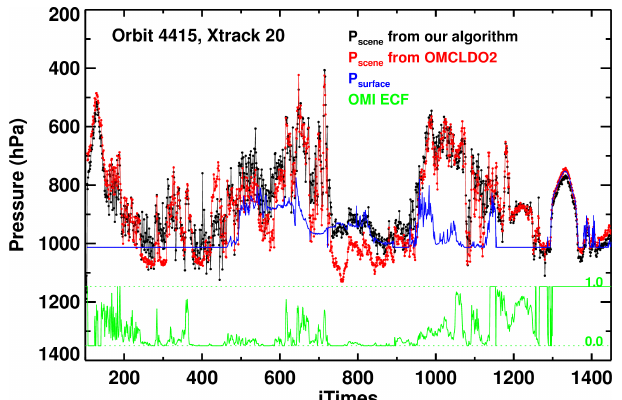
Figure 8. Comparison of scene pressures from our algorithm (black curve) and OMCLDO2 v2 (red) with surface pressures (blue) along cross-track position 20 of OMI orbit 4415 (14 May 2005). The green curve shows cloud fractions for this cross-track position.